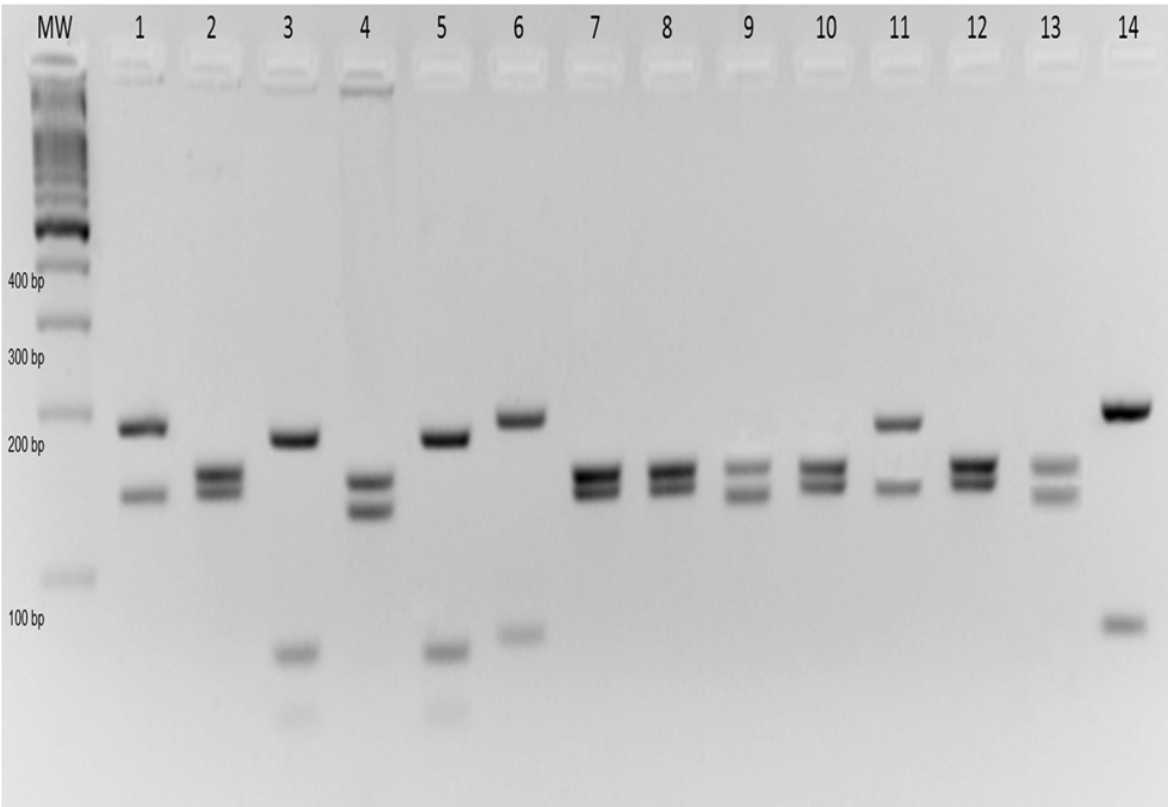
Fig 3. Species identification of Leishmania from sand flies collected from trails in the Xakriabá Indigenous Reserve, Brazil, during the study period. Sand flies were grouped in pools of up to ten specimens of the same species, locality, and date, and ITS1 PCR-RFLP was performed with total DNA extracted from these pools. The figure represents an ethidium bromide-stained 4% agarose gel in which the amplicons were submitted to electrophoresis. Lanes: MW, molecular weight marker — 100 bp; lanes 1 – 4, positive controls of Le . amazonensis (IFLA/BR/67/PH8), Le . braziliensis (MHOM/BR/75/M2903), Le . infantum (MHOM/BR/74/PP75), Le . guyanensis (MHOM/BR/75/M4147) respectively; 5 – 14, phlebotomine positive pools.